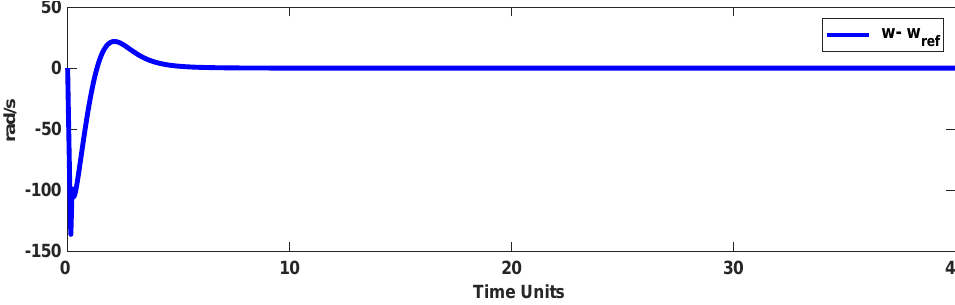
Figure 4. Rotor speed tracking error in the normal condition.